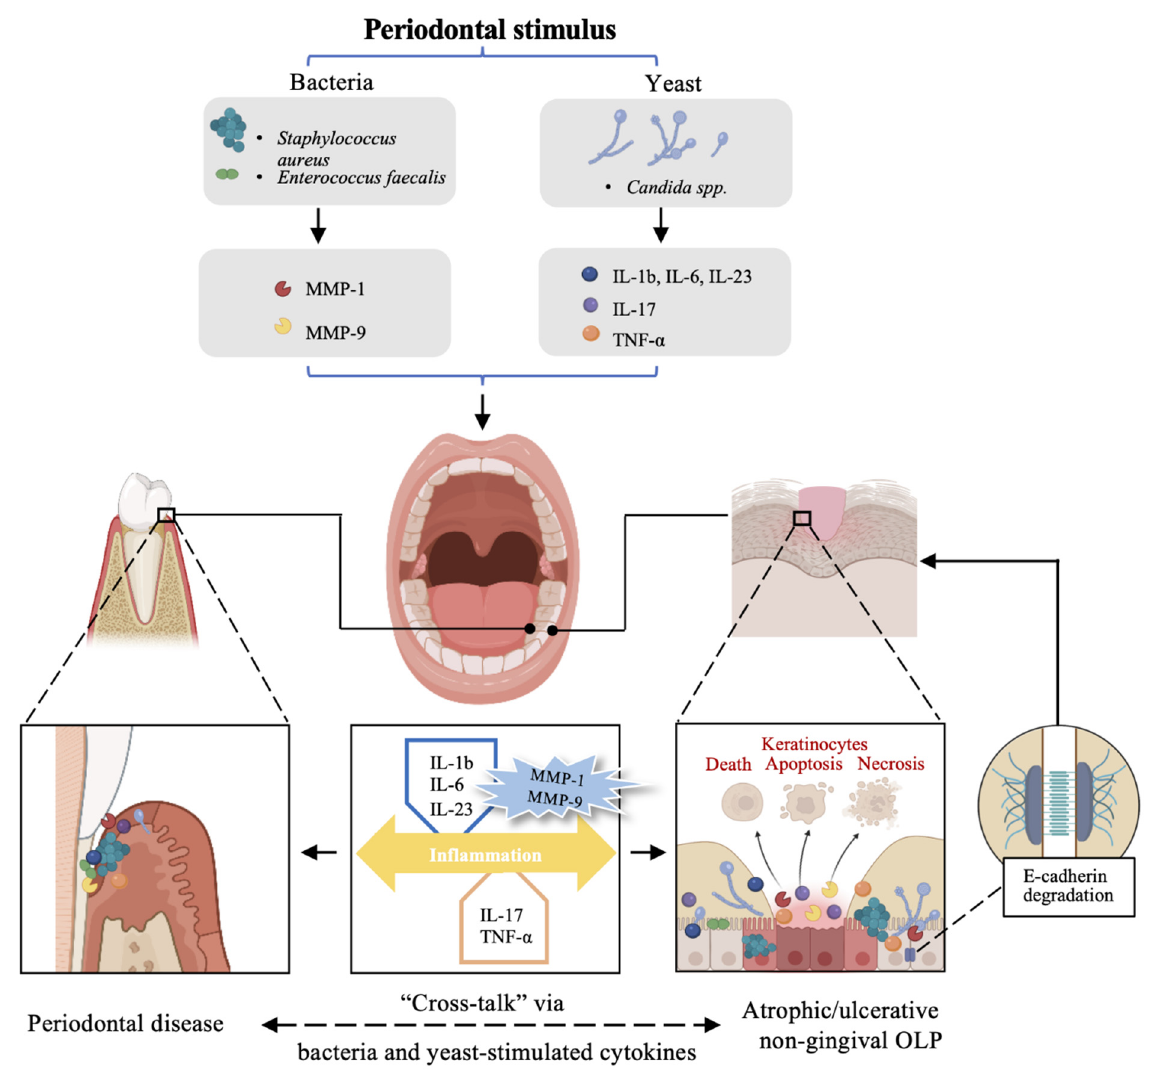
Figure 2. The hypothesis of “cross-talk” between periodontal and mucosal inflammation in OLP patients with non-gingival lesions. On one hand, bacteria and yeast-associated dental calculus or plaque could promote E-cadherin degradation, oral keratinocyte cell death, apoptosis, and necrosis, aggravating mucosal damage. On the other hand, cytokines stimulated by bacteria (MMP-1, MMP-9) and yeast (IL-1b, IL-6, IL-13, IL-17, TNF- α ) could accelerate inflammation in periodontal tissue and mucosal tissue. Removement of dental calculus and plaque could reduce yeast, bacteria, and inflammatory cytokines, subsequently, contributing to the healing of mucosal erosion and the alleviation of periodontitis. Meanwhile, the healing of OLP erosion also reduced cytokines that promoted the development of periodontitis, with an improvement of the periodontal condition.